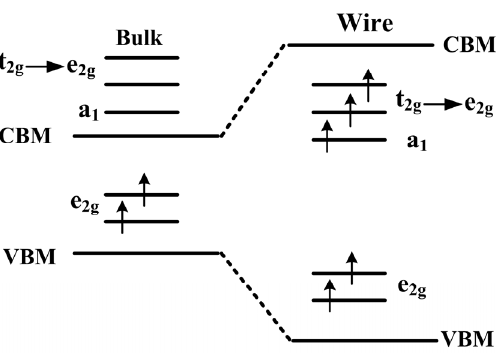
Figure 3. The schematic plot of 3d level splitting in the ZnO bulk and